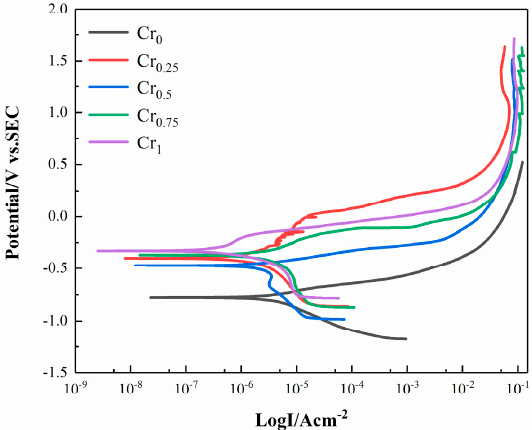
Figure 10. Tafel curve of WVTaTiCr x RHEA coating in 3.5%wt NaCl solution. Table 5. Tafel Curve Electrochemical Parameters of WVTaTiCr x RHEA coating.